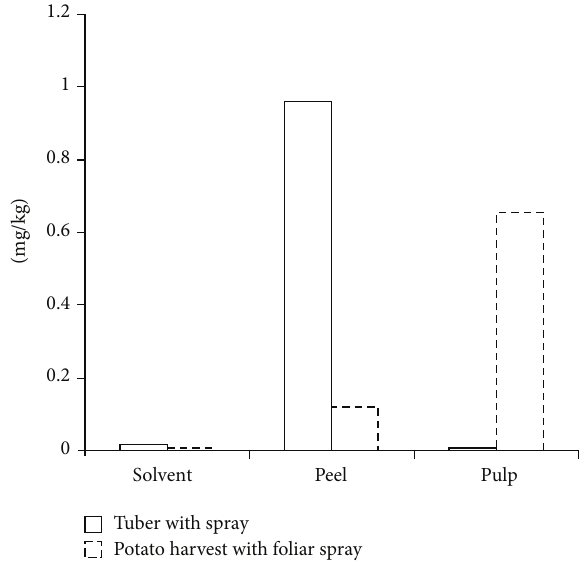
Figure3:Thecontentofpaclobutrazolwithdifferenttreatmentafter peeling and rinsing.